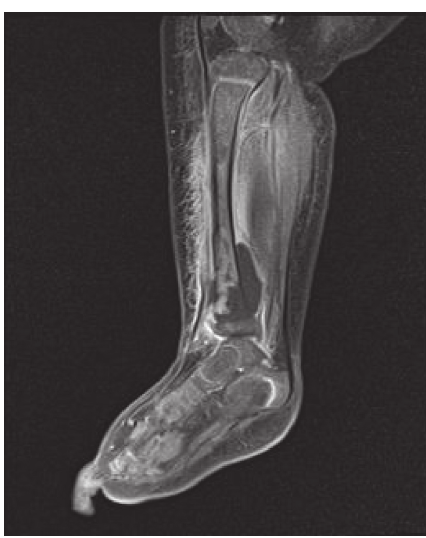
Figure 1: Osteomyelitis changes in the right tibial region by